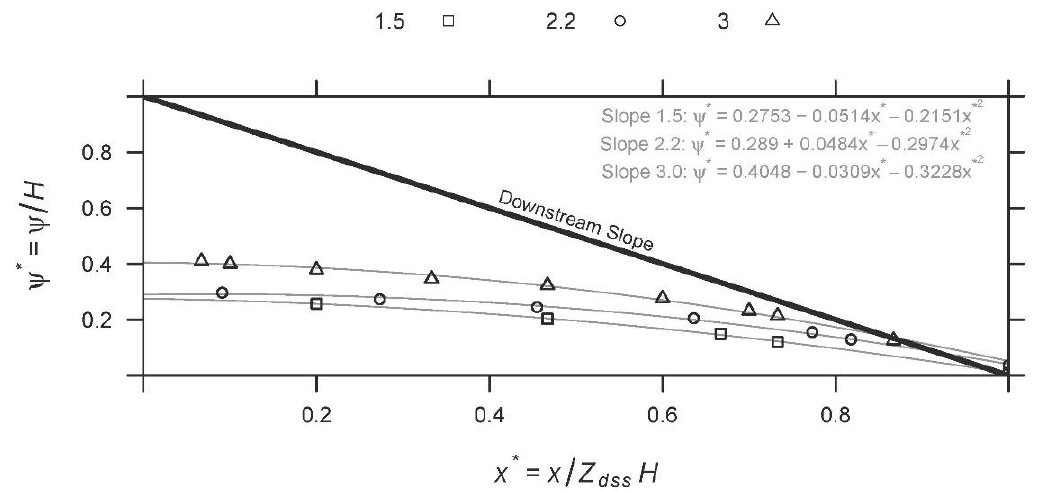
Figure 10. Hydraulic pressures measured for roughly the same discharge (0.007 m 3 s − 1 ) in tests n o 87 [ Z dss = 2.2], n o 90 [ Z dss = 1.5], and n o 94 and 95 [ Z dss = 3.0]. The plotted pressures for Z dss =